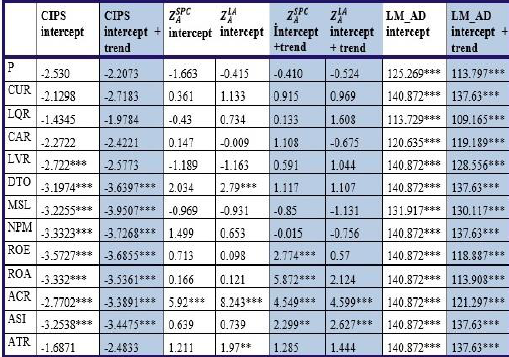
Table 3: Cross-Section Dependence and Panel Unit Root Test Results for Companies Traded in Other Countries’ Stock